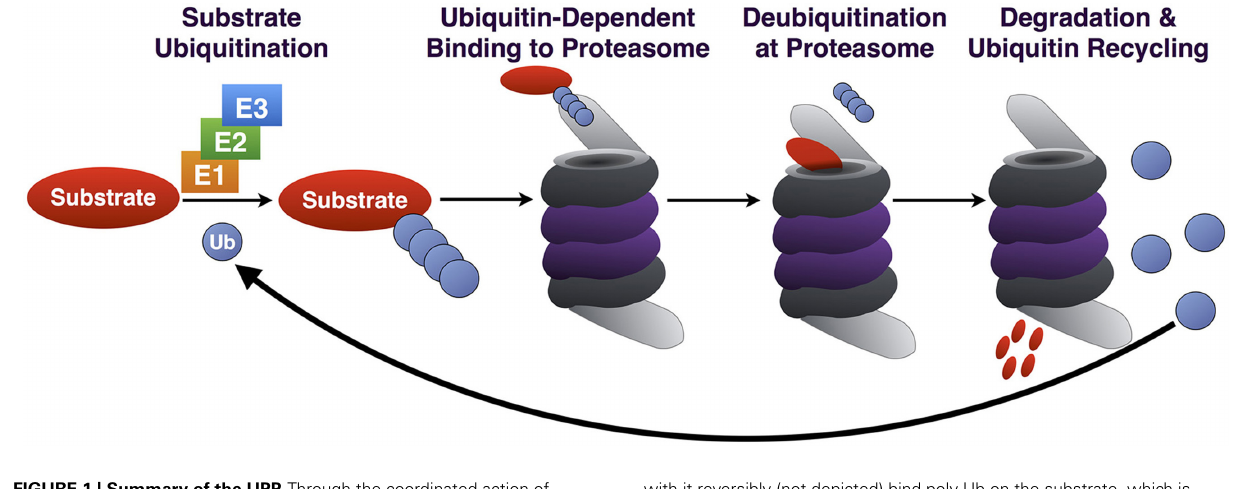
FIGURE 1 | Summary of the UPP. Through the coordinated action of E1/E2/E3, Ub is conjugated to a substrate destined for proteasomal degradation. Ub-binding proteins that are part of the 19S or that associate